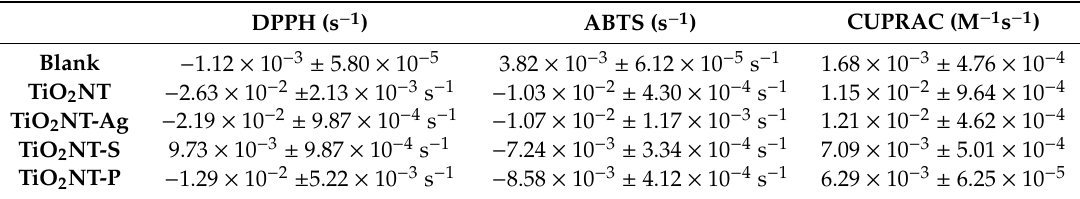
Table 3. Rate constant k for the various electron-transfer-based methods tested using first-order kinetics for DPPH and 2,2 (cid:48) -azino-bis (3-ethylbenzothiazoline-6-sulfonic acid) (ABTS), while second-order kinetics were used for cupric ion reducing antioxidant capacity